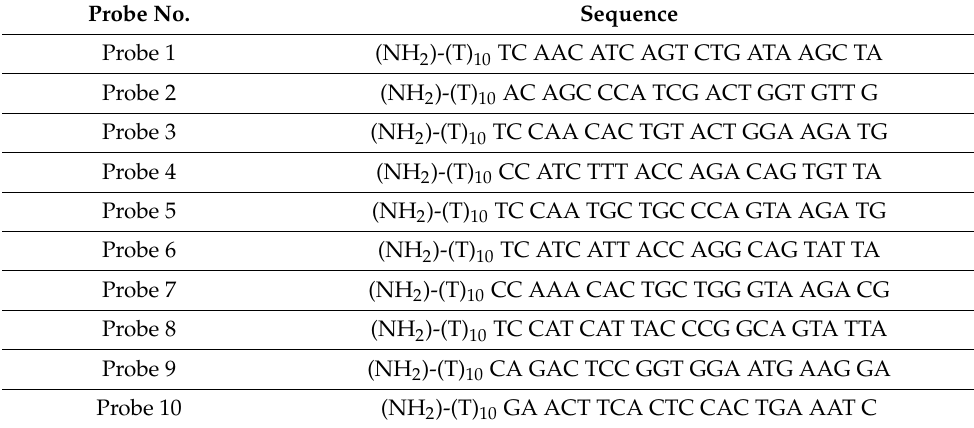
Table A1. Sequences of 10 probes specific for miRNA associated with ovarian cancer. Probe